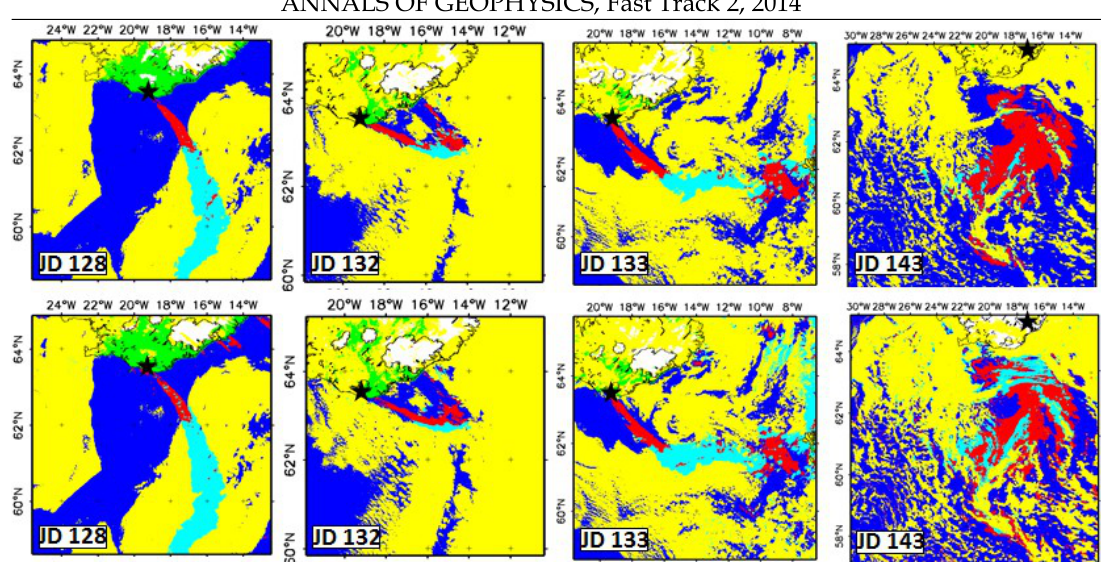
Figure 2: Standard procedure maps (upper panel). NN maps (down panel). The six classes are identified by color: Red – Ash above Sea. Cyan - Ash above meteorological clouds. Yellow – Meteorological clouds. Blue – Sea. White – Ice. Green – Land. The coastline is plotted in black. Volcano’s vents are marked by black